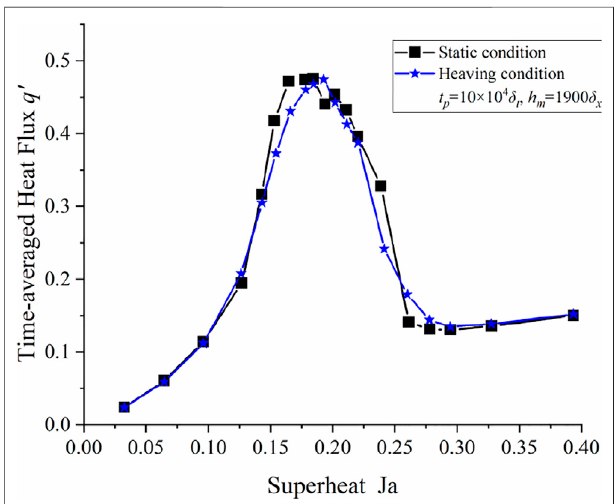
FIGURE 7 | Pool boiling curves under static and heaving